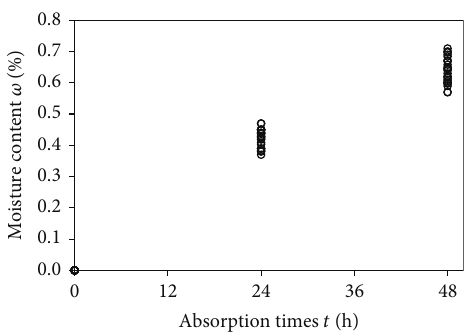
Figure 2: Moisture content of three groups of shales after di ff erent water absorption times